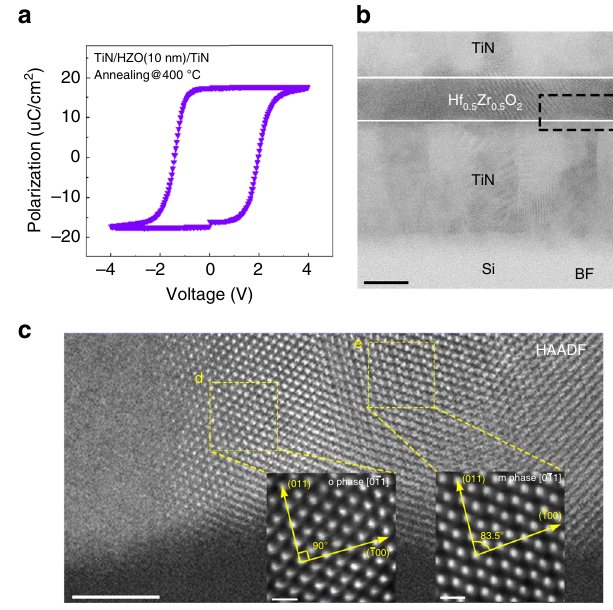
Fig. 1 Planar metal – ferroelectric – metal (MFM) capacitors. a Typical P – V loop (2.5 kHz) of the Hf 0.5 Zr 0.5 O 2 (HZO) fi lm derived from positive-up negative-down (PUND) measurements. b STEM-BF image of the TiN/ HZO/TiN stack. Scale bars, 10 nm. c STEM-HAADF image of the HZO thin fi lm with two speci fi c crystal grains, projected along o [0 (cid:1) 11] (left square) and m [0 (cid:1) 11] (right square) zone axes. Scale bars, 5 nm. Scale bar inset, 0.5